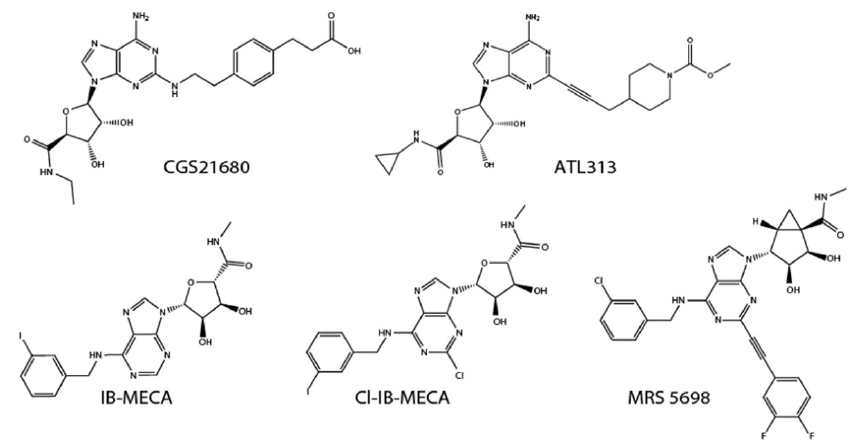
Figure 2. Structures of listed P1 receptors agonists and allosteric modulators.